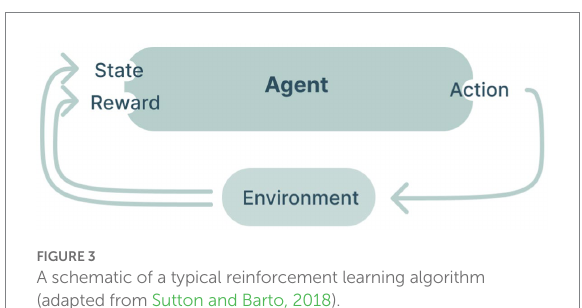
FIGURE 3 A schematic of a typical reinforcement learning algorithm (adapted from Sutton and Barto,